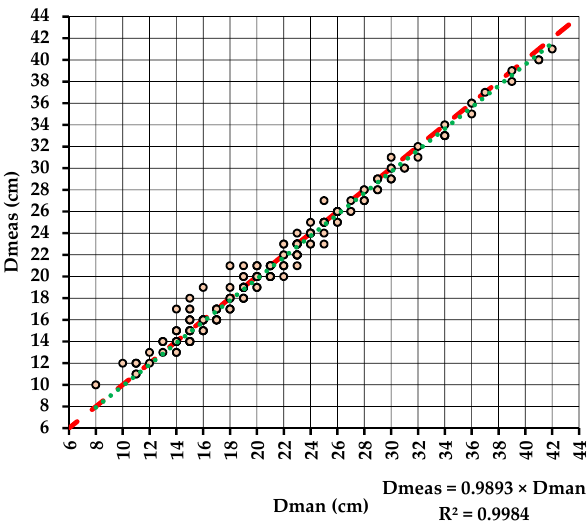
Figure 12. Relation between the diameters measured by the two methods (E2). Legend: red dashed line stands for perfect agreement and green dashed line stands for the dependence relation between Dmeas and Dman fitted by RTO.